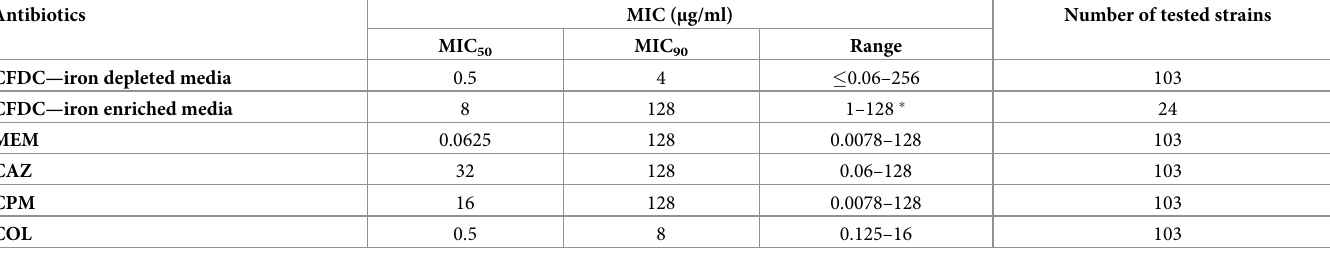
Table 2. MIC distribution for antibiotics (CFDC, MEM, CAZ, CPM and COL) tested on the bacterial strains. Antibiotics MIC ( μ